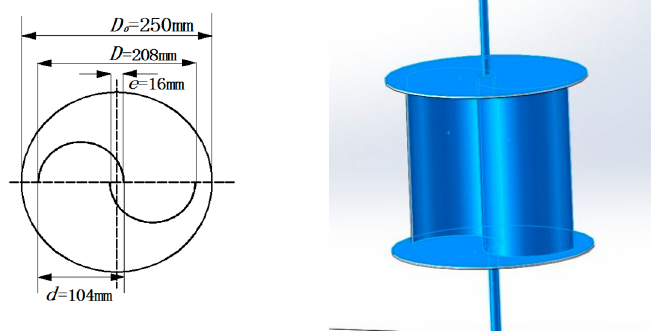
Figure 3. Geometric parameters and schematic of the wind rotor.